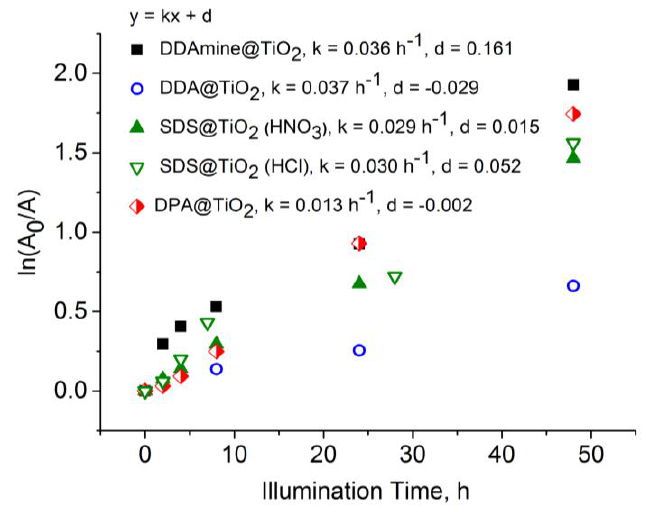
after different times of illumination. 2